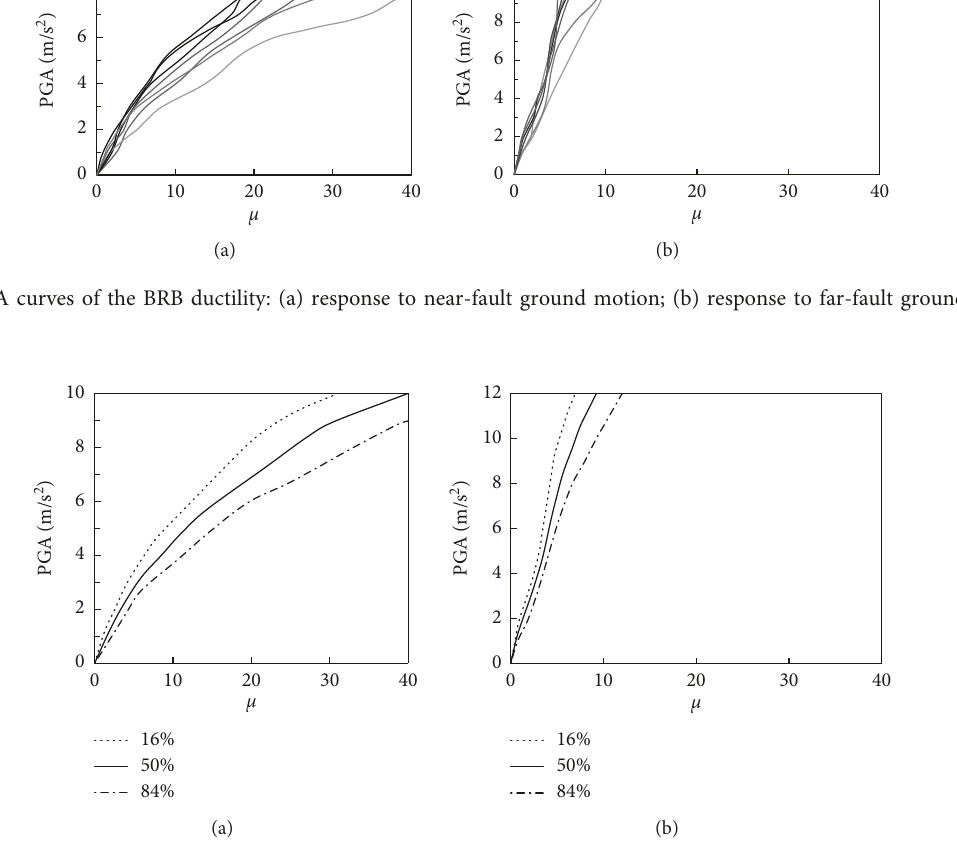
Figure 10: Distribution statistics of BRB ductility: (a) response to near-fault ground motion; (b) response to far-fault ground motion.